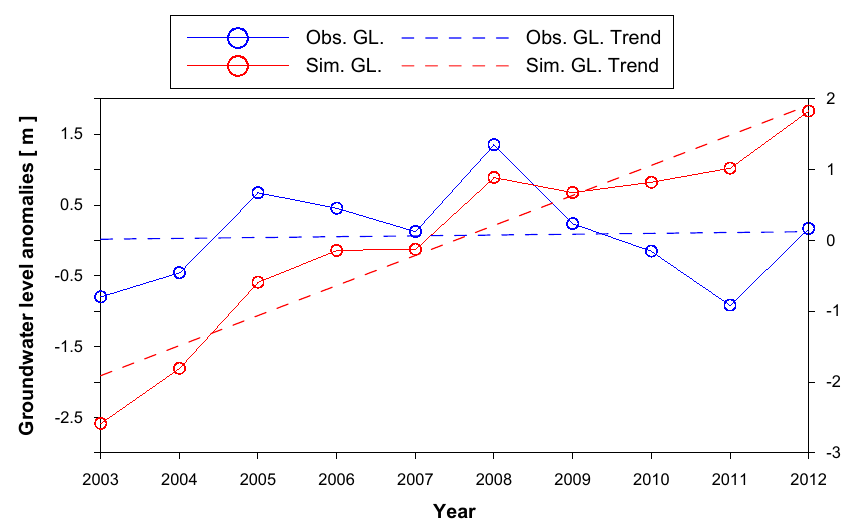
Figure 13. Annual series of observed and simulated groundwater level anomalies and corresponding linear trends. GL, groundwater